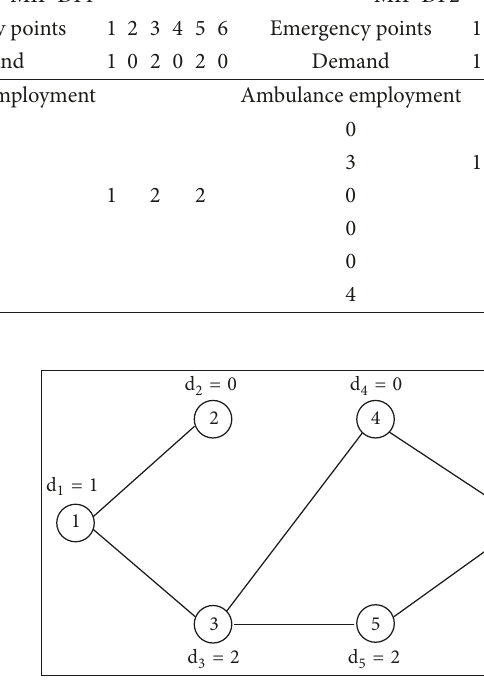
Figure 1: Instance 4 in Nickel et al. [8] under given